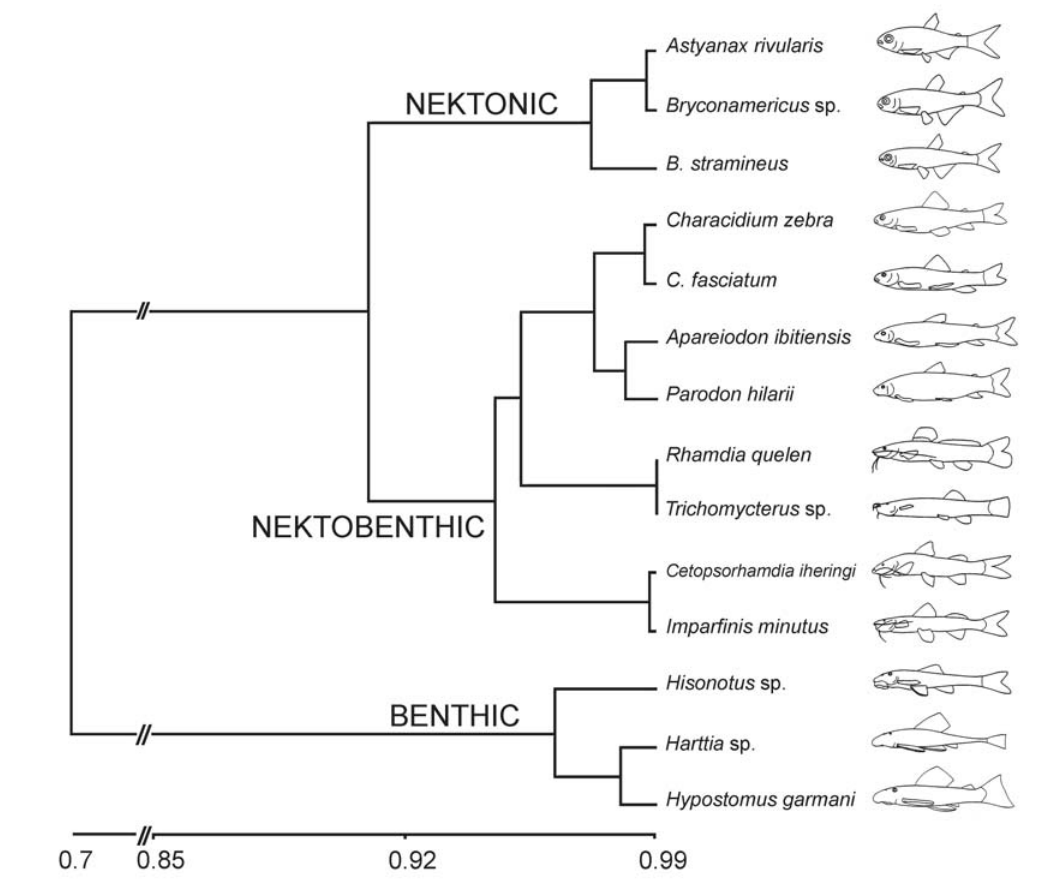
Fig. 3. Dendrogram of ecomorphological relationships of the 14 resident fish species in the upper rio São Francisco studied riffles, southeastern